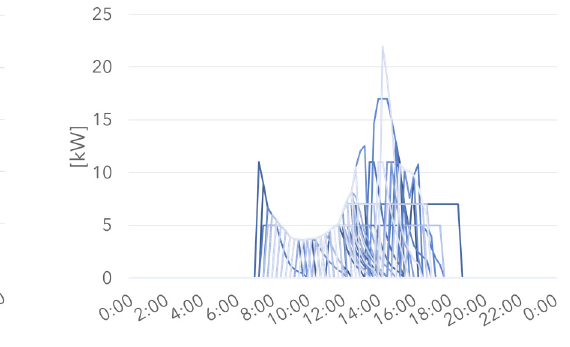
Figure 13. Input and output CMS (SA) parameters: ( a ) the PV power measurement ( red ) and the num ‐ ber of EVs charging ( blue ); ( b ) the output reference power for each charging station.